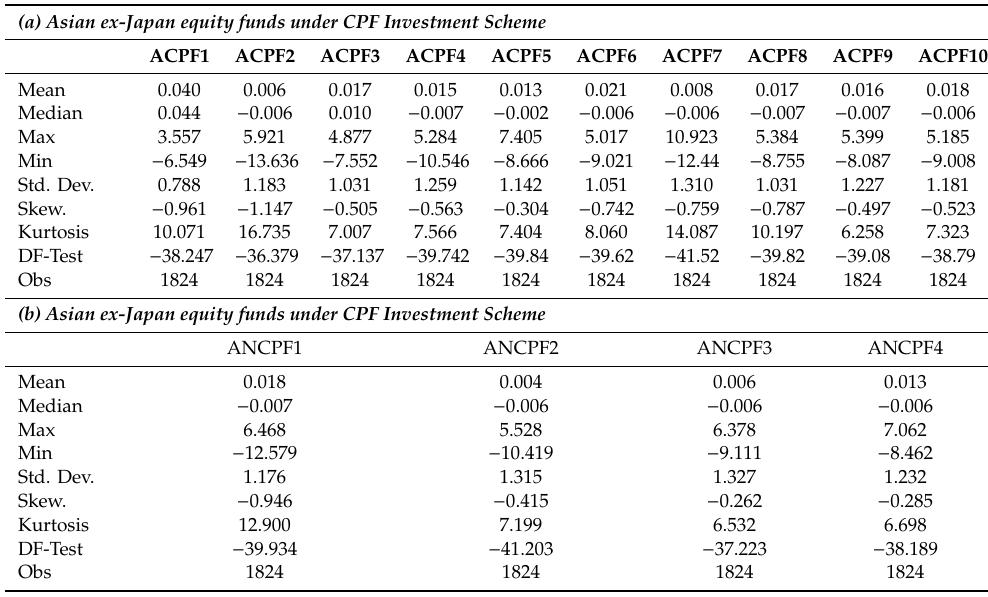
Table 3. Descriptive statistics of the excess returns of Asian ex-Japan funds under the CPF Investment Scheme and non-CPF Asia ex-Japan